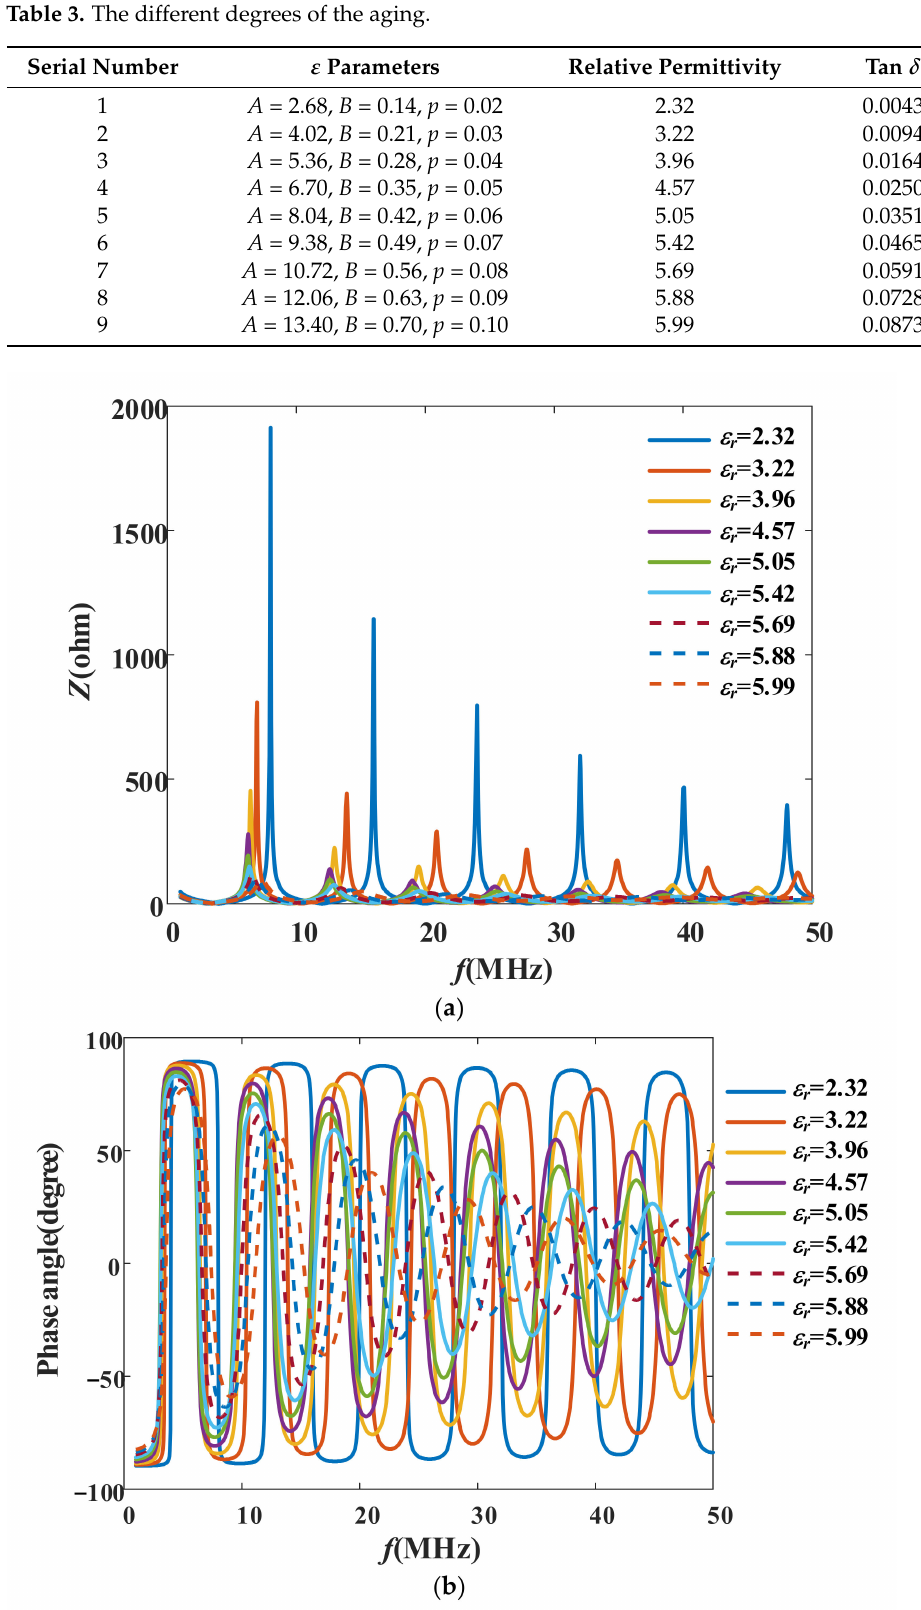
Figure 11. The impedance spectroscopy for the cables of different aging degrees: ( a ) the impedance magnitude spectroscopy and ( b ) the phase angle of the impedance